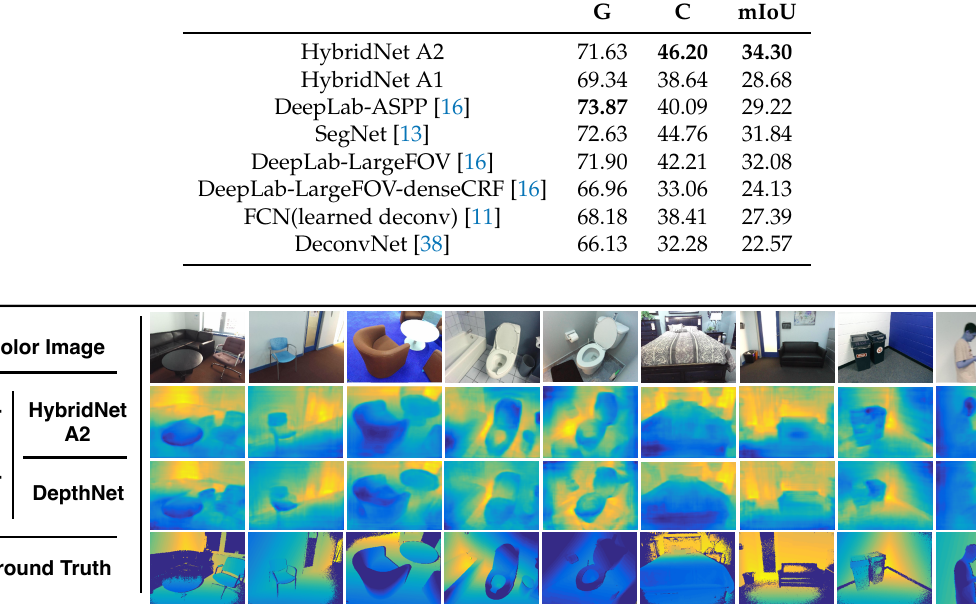
Figure 8. Depth estimation qualitative results. A comparison between depth estimations against ground truth is presented. Input image is depicted in the first row. The 2nd, 3rd and 4th rows present the estimated depth map of our method, DepthNet and the ground truth, respectively.